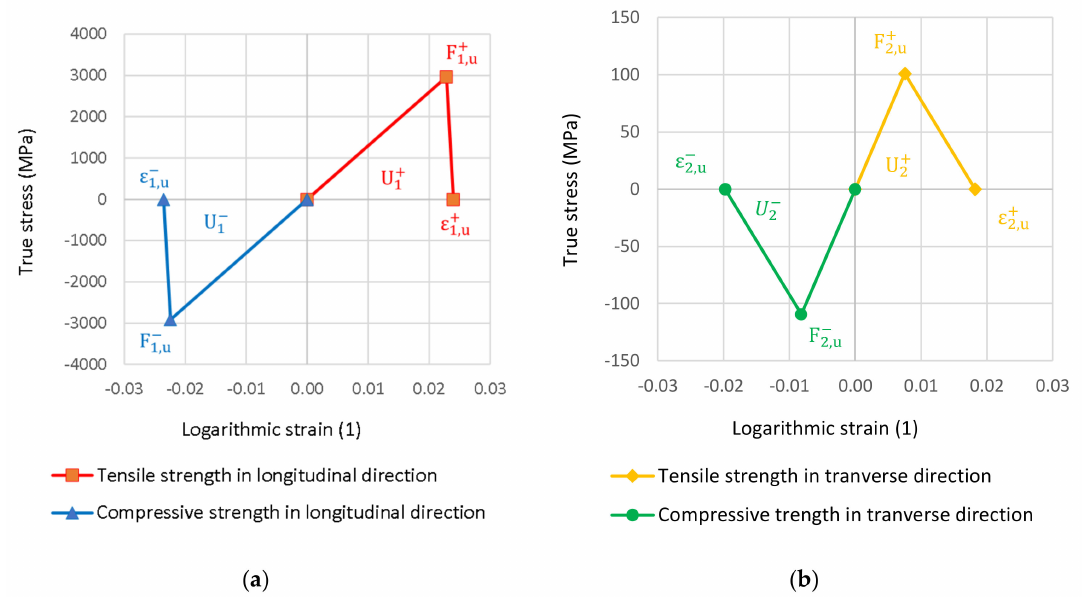
Figure 8. Hashin damage diagram in longitudinal ( a ) and transverse laminate ( b ) direction.